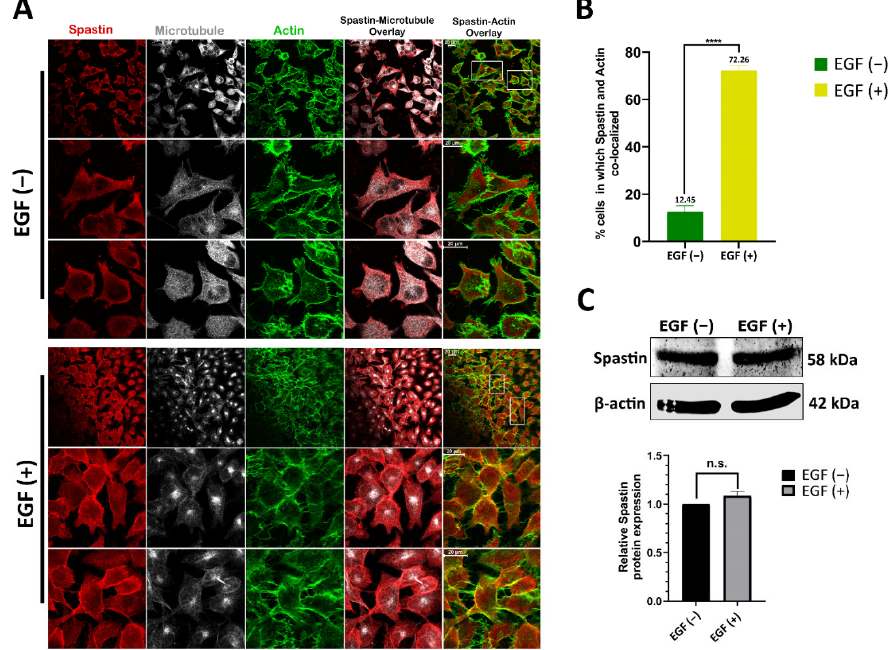
Figure 3. Spastin is directed to actin filaments upon stimulation with EGF. ( A ) The co-localization of Spastin with actin upon EGF treatment was analyzed by immunocytochemistry (ICC) analysis. T98G cells were treated with EGF for 24 h, and non-treated cells were used as controls. For the ICC analysis, cells were fixed with mixed-aldehyde and stained with Spastin antibody (red), microtubule antibody (gray), and phallacidin (green). The lower two panels for each section show higher magnification views of the boxed areas indicated in the upper panels. ( B ) Bar graphs show the percentage of cells possessing Spastin co-localization with actin filaments in control and EGF-treated conditions. The quantification was performed by dividing the number of EGF-treated cells containing Spastin co-localization with actin to the number of untreated control cells containing Spastin co-localization with actin. Results were statistically analyzed by unpaired t-test ( n > 150) and data are represented as mean ± SD; **** p < 0.0001. ( C ) Spastin expression was detected with Western blot (WB) using a specific antibody to Spastin. Representative WB is shown, and relative densitometric values of Spastin/ β -actin are reported in the lower panel. Molecular weights of the proteins are reported in kilodalton (kDa). Data are represented as mean ± SD. n.s. p >